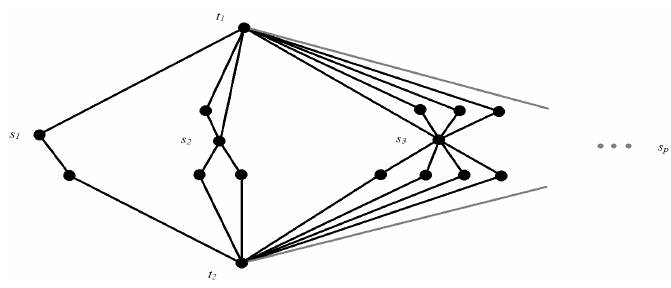
Figure A1. Construction of Example